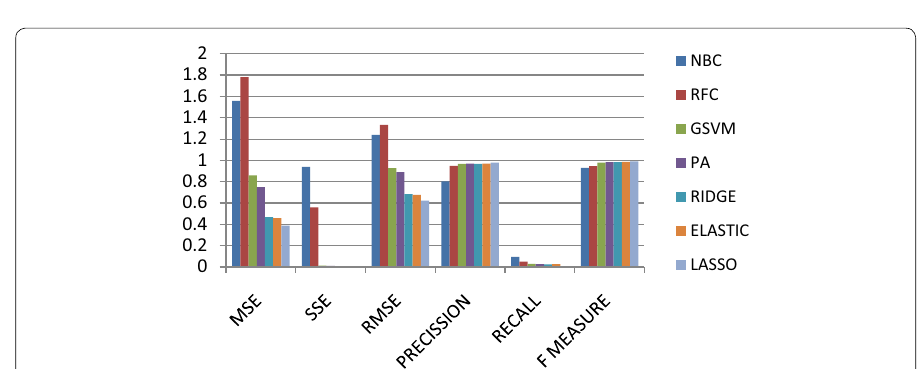
Fig. 5 Performance metrics for different classifiers under LFW